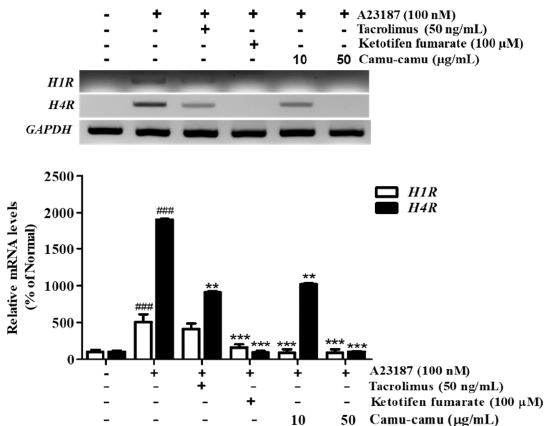
Figure 4. Effect of camu-camu fruit extract on mRNA expression of H1R and H4R in A23187-induced RBL-2H3 cells. Normalized mRNA amount was relatively compared to GAPDH . The results were calculated as percentage of non-treated cells and displayed as mean ± SD of three independent ex- periments ( ### p < 0.001 vs. the control group, ** p < 0.01 and *** p < 0.001 vs. the A23187-treated